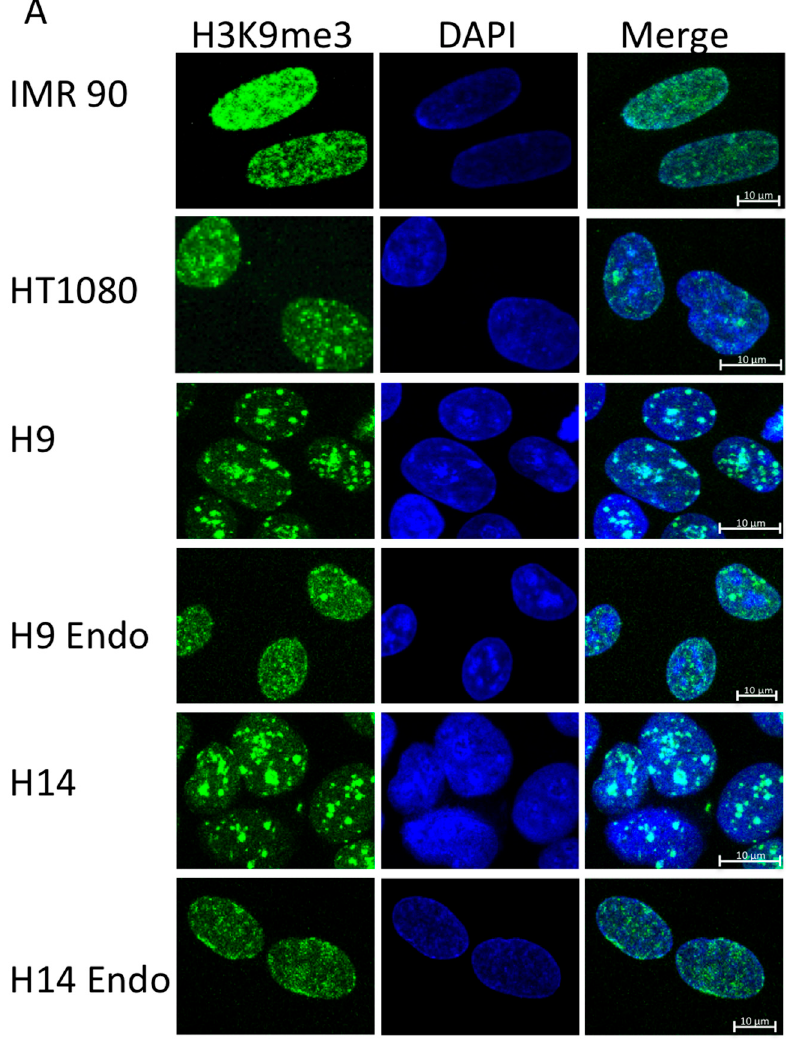
Figure 1. Cont. Figure 1.